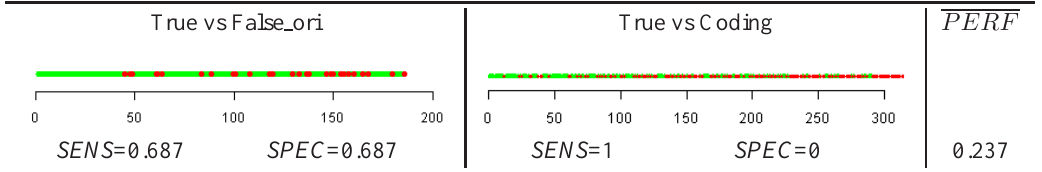
Table 4: Performance of ranking aggregation and symbolic plots of ranked lists. In the plot, true and negative targets are displayed in green and red respectively. Axis shows the ranking